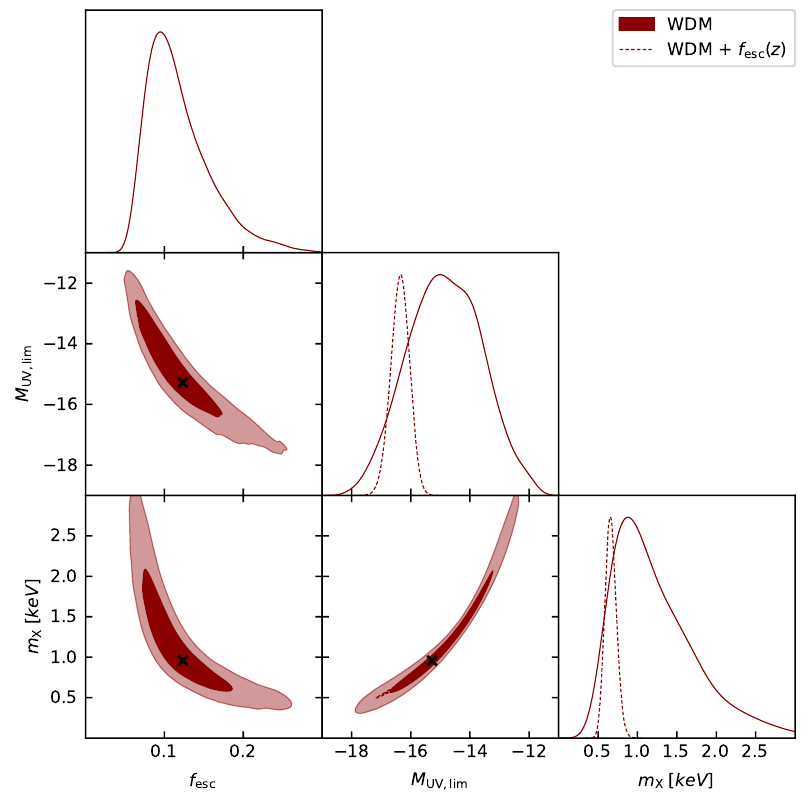
Figure 5. MCMC posterior distributions in the WDM scenario (red contours/lines), for the escape fraction f esc of ionizing photons, the limiting UV magnitude M UV,lim , and the DM particle’s mass m X . The dashed lines refer to a run where the escape fraction has been set to the redshift dependent values from the radiative transfer simulations by [91]. The contours show 68% and 95% confidence intervals, the black cross shows the maximum likelihood position, and the marginalized distributions are in arbitrary units (normalized to 1 at their maximum